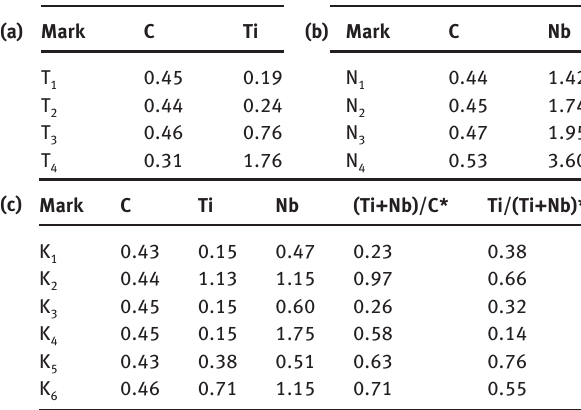
Table 3: Chemical compositions of HK40 with the cooling rate according to casting condition [15].